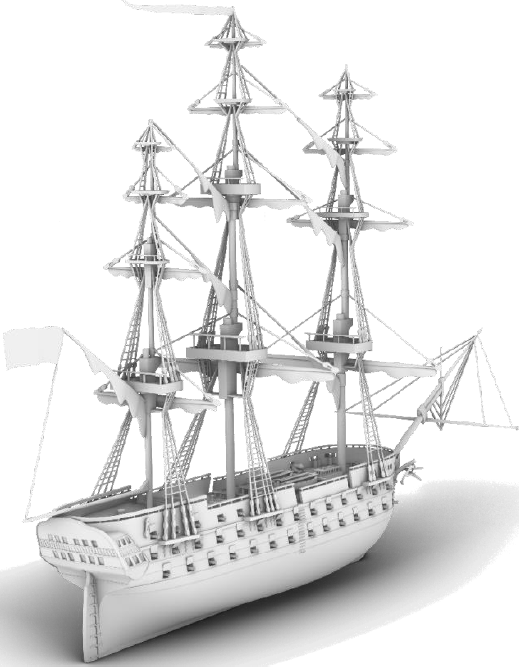
Figure 4 . The fully rigged 3D model of Azov (from the stern).